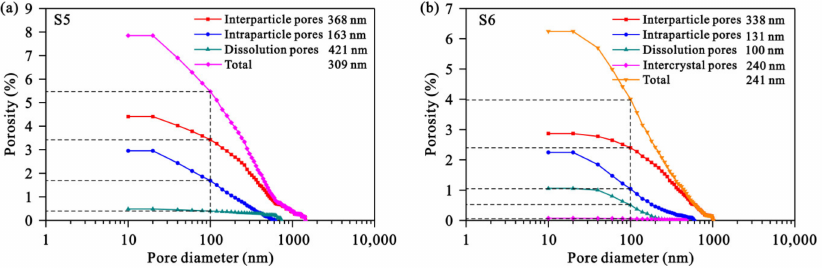
Figure 10. Pore size distributions in felsic shales: ( a ) S5; ( b )